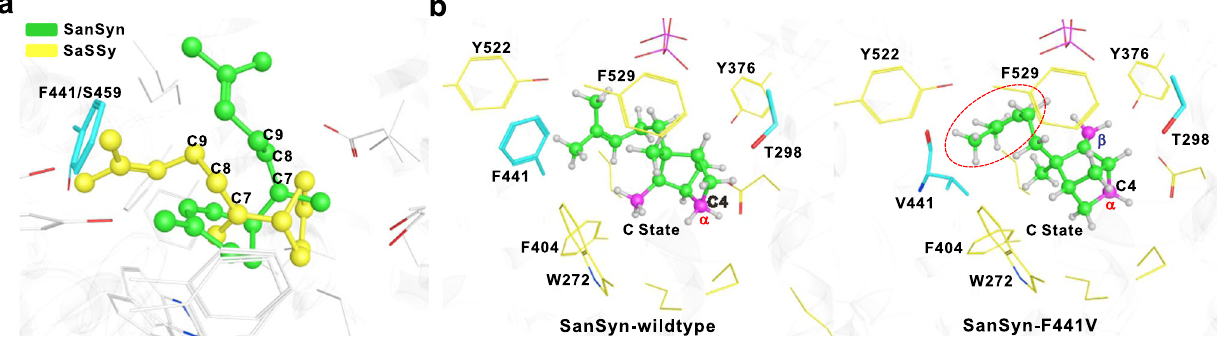
Fig. 3 Comparative analysis of the active cavities of SaSSy, SanSyn, and SanSyn F441V . a Comparisons of the A state conformations in SaSSy (yellow) and SanSyn (green). b The C state conformations in SanSyn and SanSyn F441V . The space released by F441V mutation is indicated by the red dashed